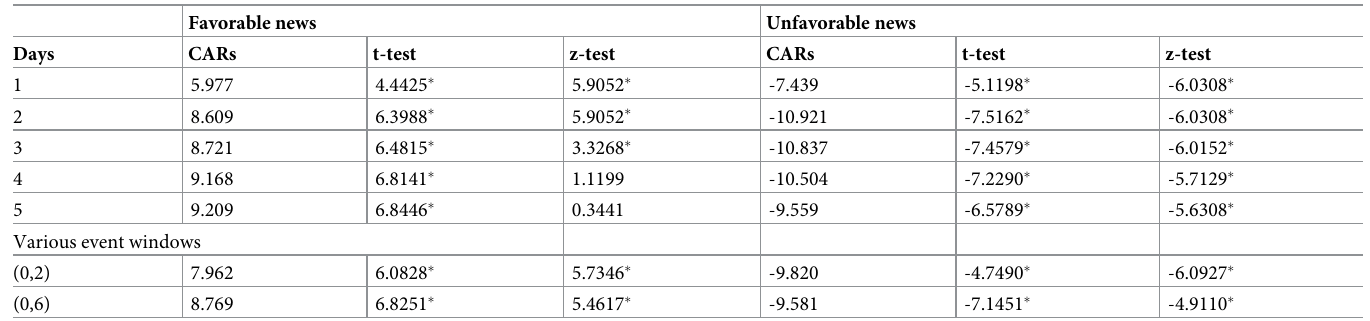
Table 6. Post-event CARs for the second sub-period (1.01.2014–10.03.2020)–favorable and unfavorable